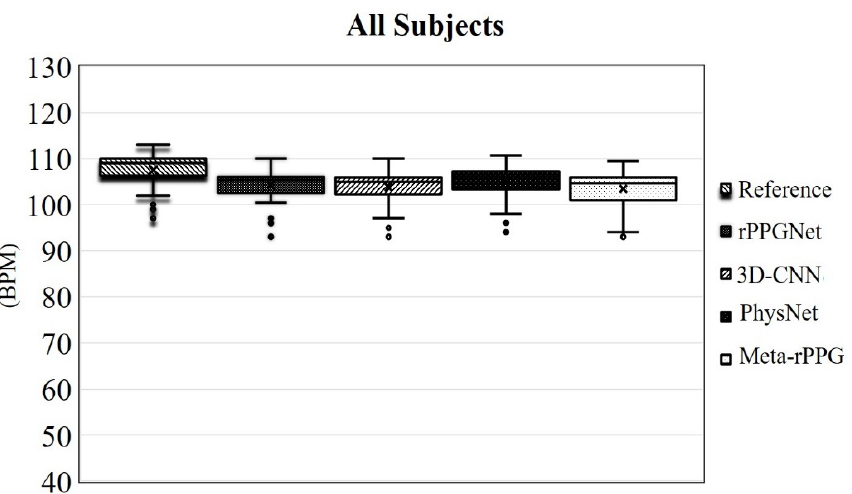
Figure 14. Averaged heart rate measurement of all the subjects in the test set. The vertical axis indicates the heart rate for each method in bpm. Each bar shows the mean and the standard deviation of a method. The first bar from the left indicates the reference.